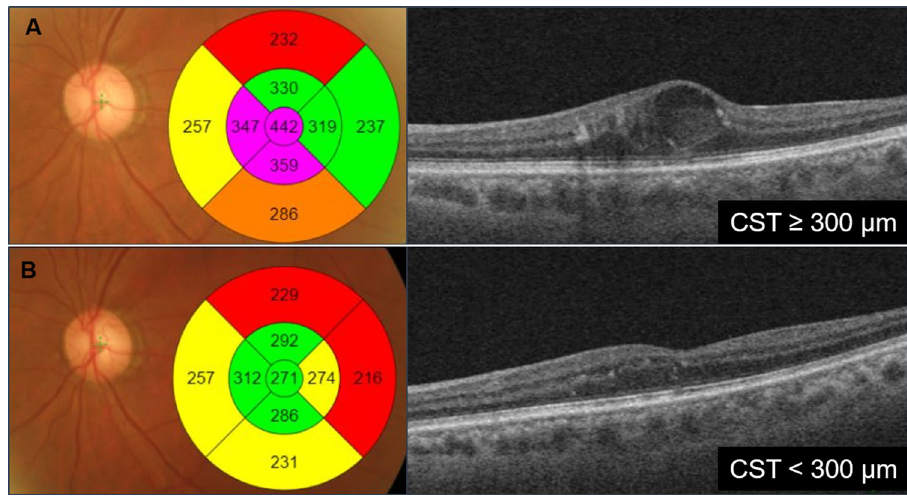
Figure 1. Changes in CST after intravitreal anti-VEGF injection. ( A ) Before, and ( B ) after 1 month. CST: central subfield